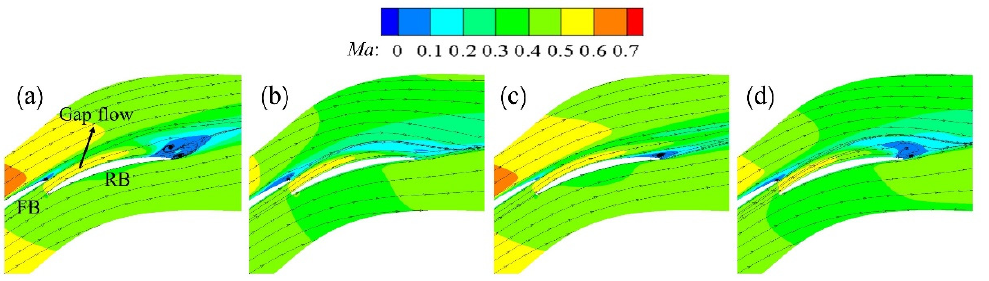
Figure 17. The distributions of mass pitch-averaged outlet total pressure loss coefficient and outlet flow angle of the tandem cascade along the spanwise: ( a ) Total pressure loss coefficient; ( b ) Outlet flow angle.